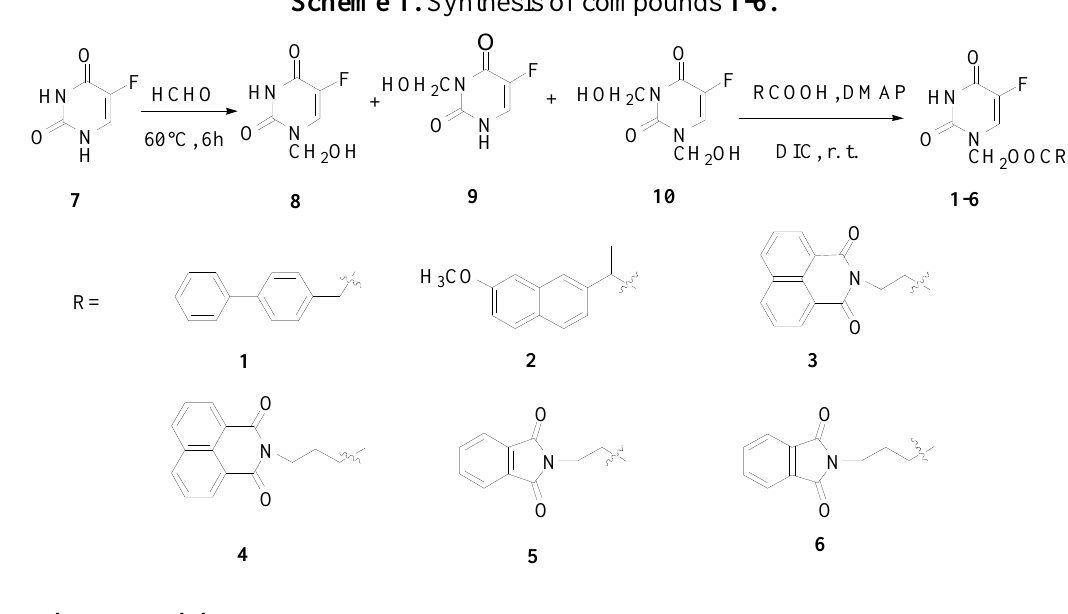
Scheme 1. Synthesis of compounds 1-6.